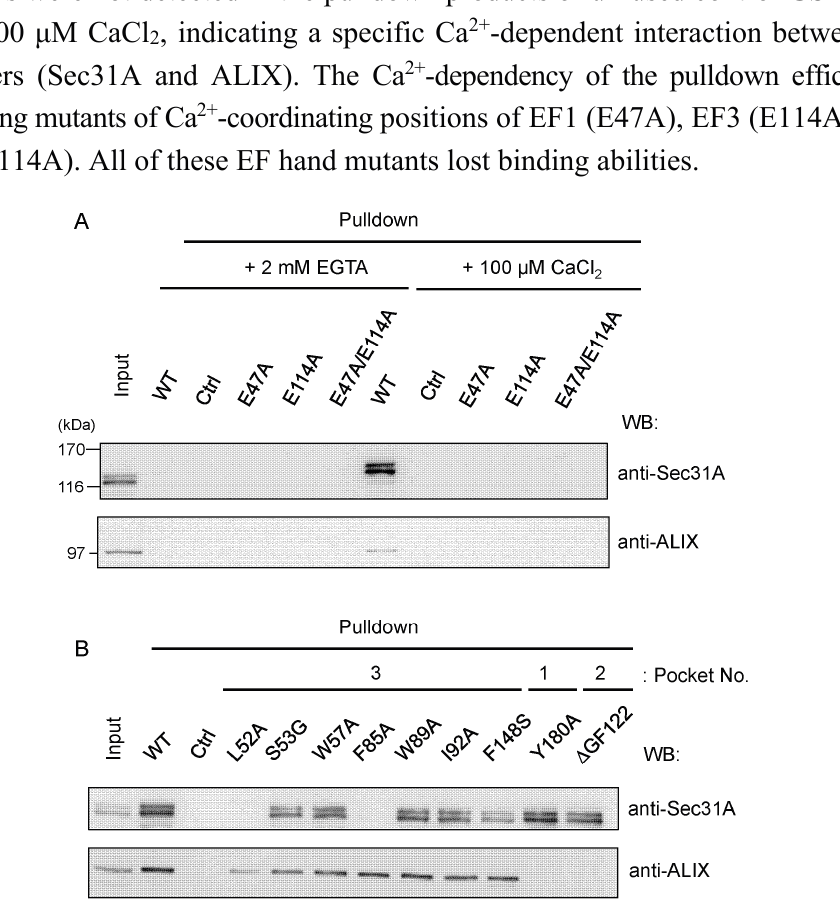
Figure 6. Glutathione- S -transferase (GST)-pulldown assays of ALG-2 mutants. Endogenous Sec31A and ALIX in ALG-2-knockdown HEK293 cells (HEK293/ALG-2 KD cells) were pulled down with GST-fused wild-type (WT) and mutant ALG-2 proteins of ( A ) EF-hands ( E47A , EF1; E114A , EF3; E47A / E114A , EF1 and EF3) and ( B )